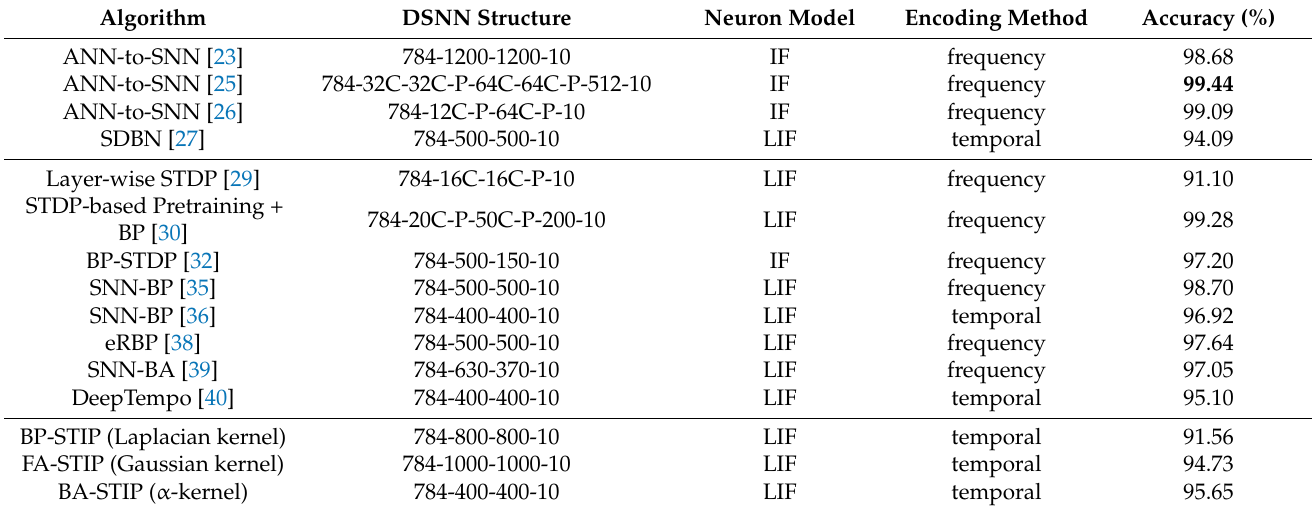
Table 3. Comparison of classification accuracy of different deep learning algorithms on MNIST